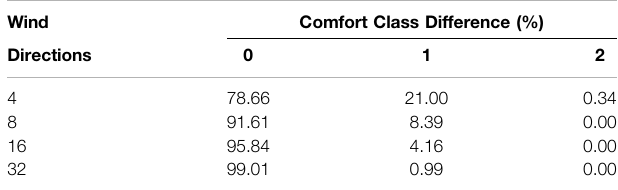
eachhorizontaldirectionofthehigh-risebuildinganddoesnotincludethebuilding footprint area. This table provides numbers for the areas seen in Figure 8